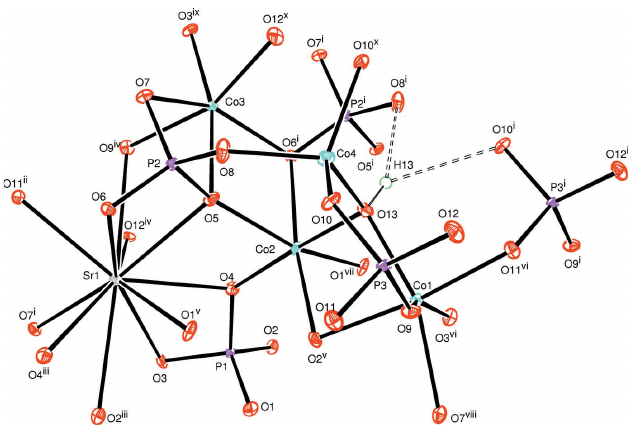
Figure 1 The interconnection of [CoO 6 ] and [CoO 4 ] polyhedra, and the hydroxide group linked to PO 4 tetrahedra through a bifurcated hydrogen bond (dashed lines). Displacement ellipsoids are drawn at the 50% probability level. [Symmetry codes: (i) (cid:5) x , y + 1 x (cid:5) 1, y , z ; (iv) (cid:5) x + 1